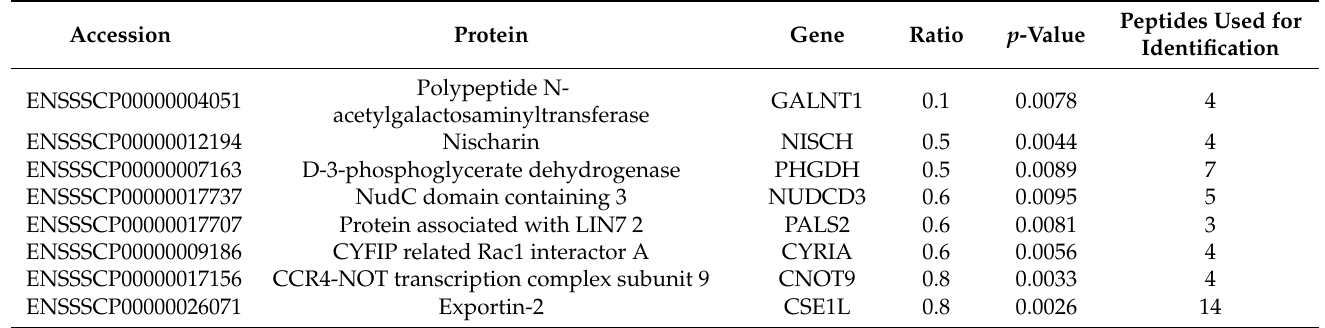
Table 3. Proteins from mass spectrometry dataset. Significantly ( p ≤ 0.01) differential.ly abundant proteins quantified with more than 2 peptides in CD4 + PBMCs of GHR -KO pigs ( n = 4) compared to WT pigs ( n = 5).